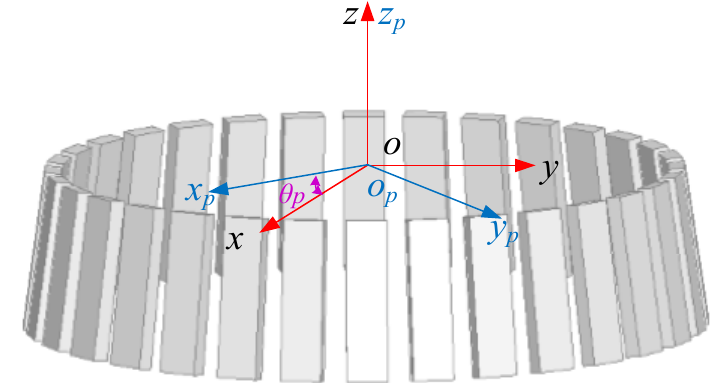
Figure 6. Total poles in the ( o p - x p , y p , z p ) coordinate system and ( o - x, y, z ) coordinate system.